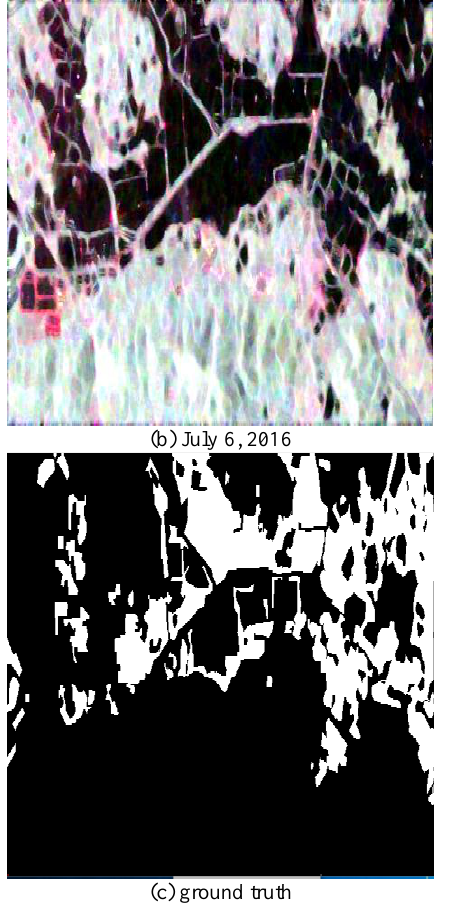
Figure 4. The Pauil-RGB images of Liangzi Lake on (a) Jun.25, 2015; (b) Jul.6, 2016; (c) ground truth